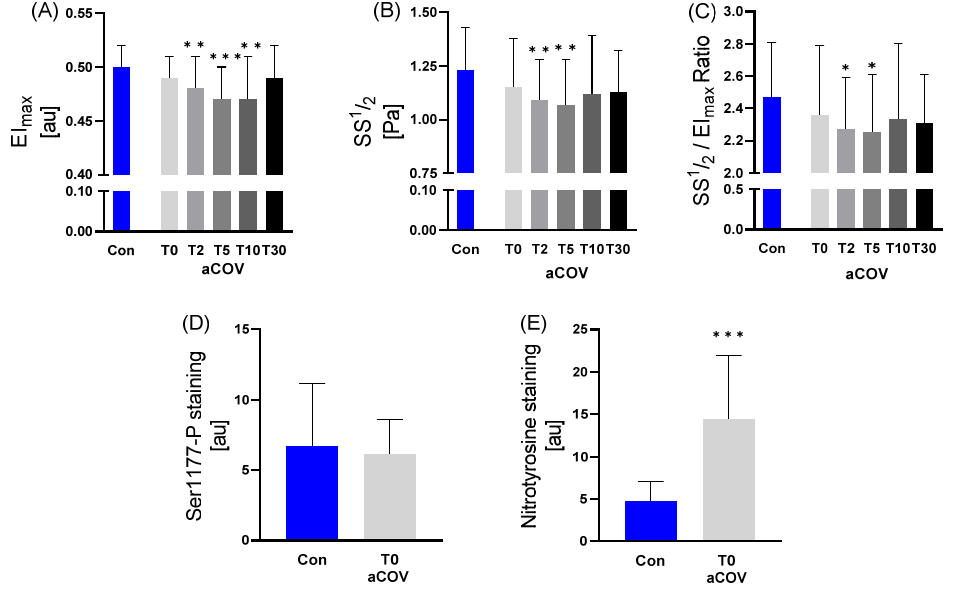
Figure 4. Deformability variables assessed for acute COVID-19 infected individuals (aCOV) at different time points at the intensive care unit (T0 hospital admission; T2 day 2; T5 day 5; T10 day 10; T30 day) compared to healthy controls (Con). In aCOV, values for ( A ) EI max (T2, T5 and T10), ( B ) SS½ (T5 and T10) and ( C ) SS½/EI max ratio (T5 and T10) were significantly lower compared to Con. ( D ) RBC-NOS activation indicated by serine1177 phosphorylation was not different in aCOV compared to Con, whereas ( E ) RBC nitrotyrosine staining in aCOV showed higher values. There was no significant change observed during the 30 days of treatment in the deformability variables.